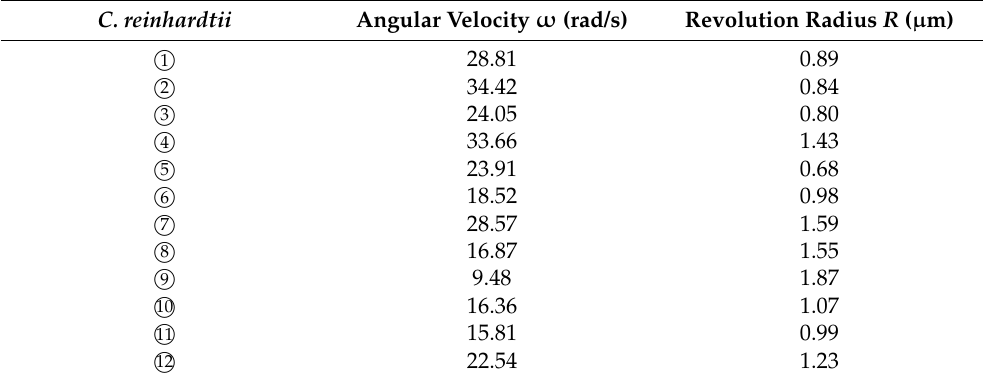
values. The revolution radius was calculated to be R = 1.16 × 10 − 6 m and the angular velocity was ω = 22.75 rad/s.